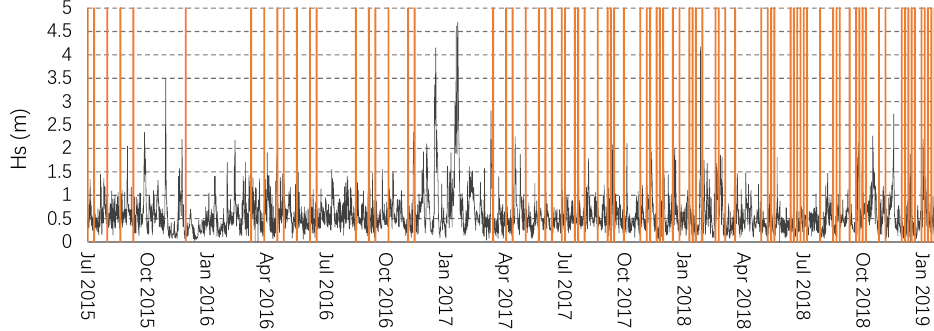
Figure 2. In black color, significant wave height (m) for the coastal segment around the Valencia Port (Spanish Port Authority, SIMAR point 2081114) along the study period (2015–2019). In orange, Sentinel-2 is considered for SDS extraction. The presence of clouds over the shore is the cause of data gaps, forcing use of a slightly smaller quantity of images at certain segments.